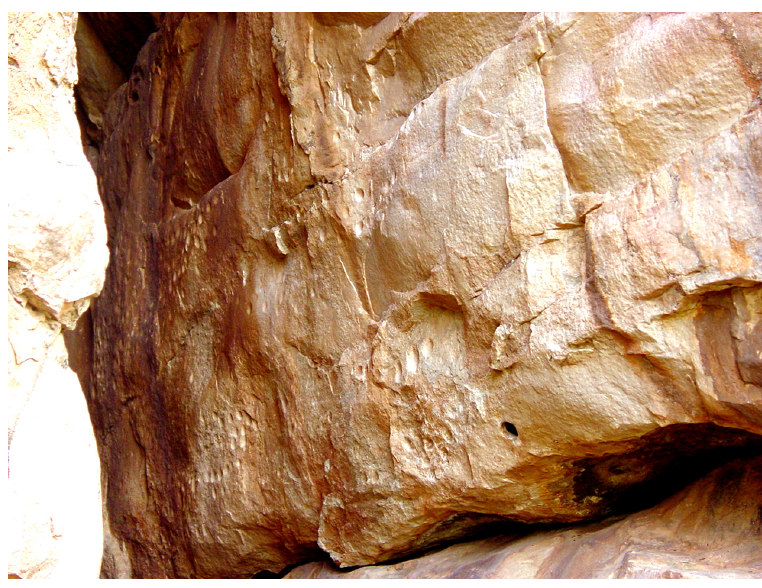
Figure 3. Daraki-Chattan cave (DC) southern wall with front portion devoid of cupules because of